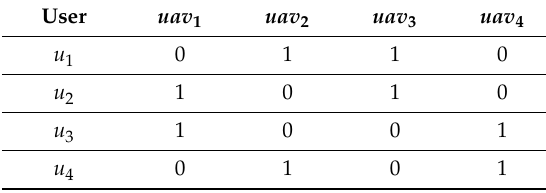
Table 2. Matrix UUA A .